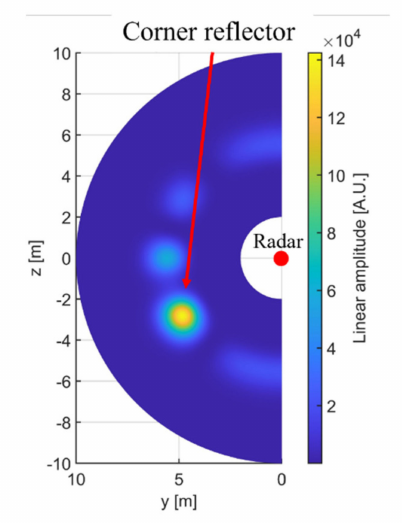
Figure 10. Radar image focused on the vertical plane at x = − 0.5 m.